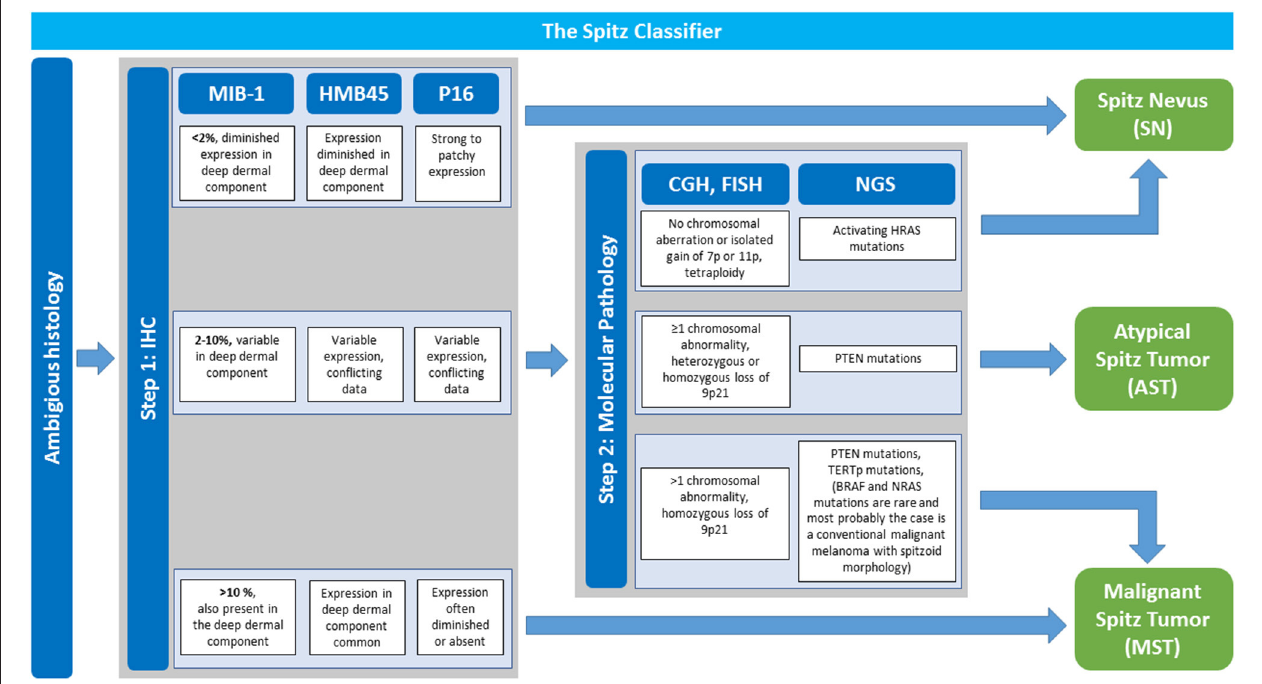
FIGURE 4 | The Spitz classifier: Stepwise Implementation of Immunohistochemistry and Molecular Pathology in Ambiguous Spitzoid Neoplasms. In cases with ambiguous histopathological features that give suspicion for malignancy stepwise ancillary studies are performed to render the diagnosis of a Spitz nevus (SN), atypical Spitz tumor (AST) or malignant Spitz tumor (MST) with more security. Step 1 is immunohistochemistry (IHC) with a panel of MIB-1-, HMB45-, and p16 antibody. In dependence of the obtained result a diagnosis of SN or MST can be made. A MIB-1 IHC index < 2% with diminished expression in the deep dermal component as well as diminished HMB45 IHC expression in the deep dermal component and patchy to strong p16 IHC expression throughout the lesion favors the diagnosis of SN. Cases with MIB-1 IHC expression > 10%, persisting HMB45 IHC expression in the deep dermal component as well as loss of p16 IHC expression favor the diagnosis of MST although exceptions of this rule are possible. If results of IHC investigation are intermediate with a MIB-1 IHC index of 2–10%, and/or variable HMB45- and p16 IHC expression one should proceed to step 2 with implementation of molecular pathology. Comparative genomic hybridization (CGH) analysis or if not available fluorescence in situ hybridization (FISH) are performed. Next generation sequencing (NGS) is of help as well. No detectable chromosomal aberration or isolated gain of Chr. 7p or 11p as well as activating HRAS mutation favor the diagnosis of a SN. The presence of at least one chromosomal abnormality (excluding Chr. 7p or 11p gain), especially homozygous loss of Chr. 9p11 as well as PTEN and TERT p mutations argue for MST. If the afore mentioned findings are only partly present with ≥ 1 chromosomal abnormality (including heterozygous and very rarely homozygous loss of Chr. 9p21), or PTEN mutations AST as a diagnosis per exclusionem is to be considered. Adapted from WHO 2018 classification